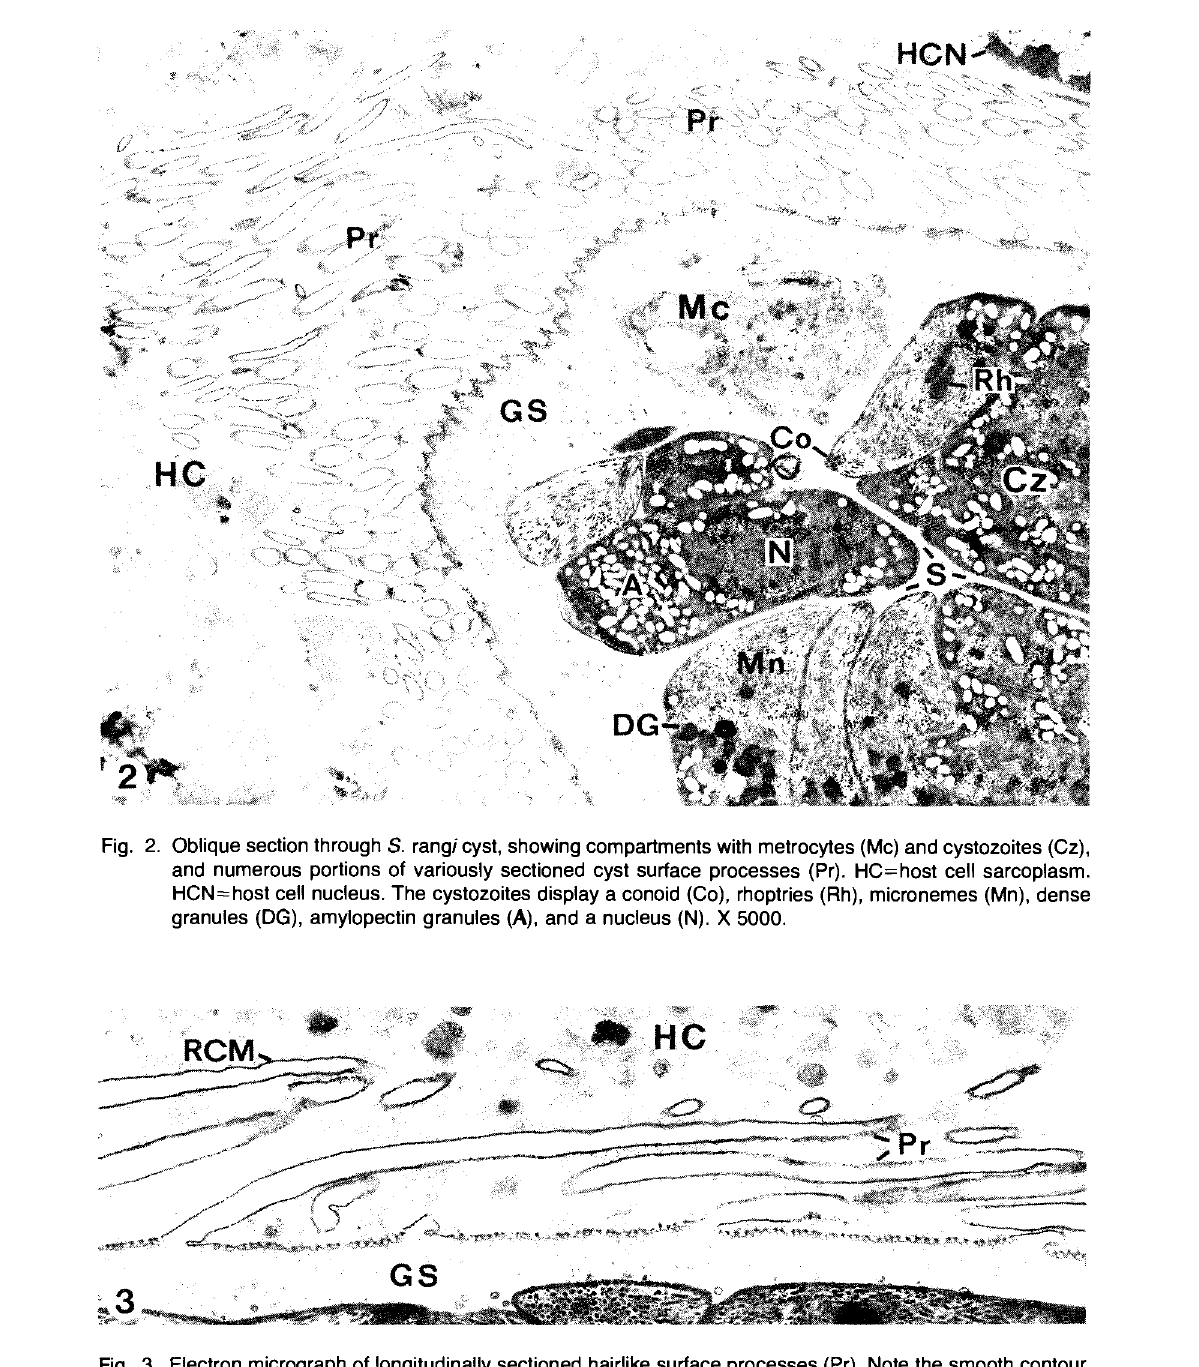
Fig. 3. Electron micrograph of longitudinally sectioned hairlike surface processes (Pr). Note the smooth contour of the projections and the serrated contour of the cyst surface between the bases of the projections. The peripheral layer of ground substance (GS) makes up the inner layer of the cyst wall. RCM=reinforced cyst membrane. X 10 000. RANGIFER, 5 (2),